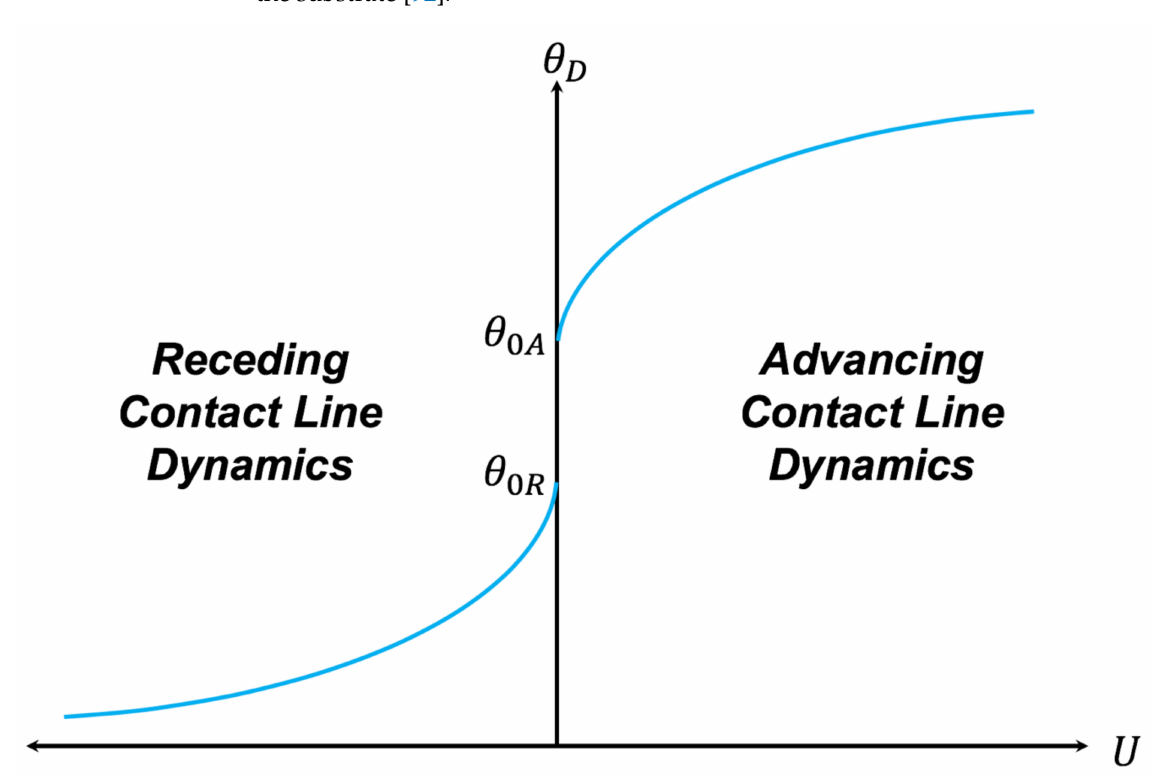
Figure 2. Relation between contact line velocity and dynamic contact angle for advancing contact line dynamics and receding contact line